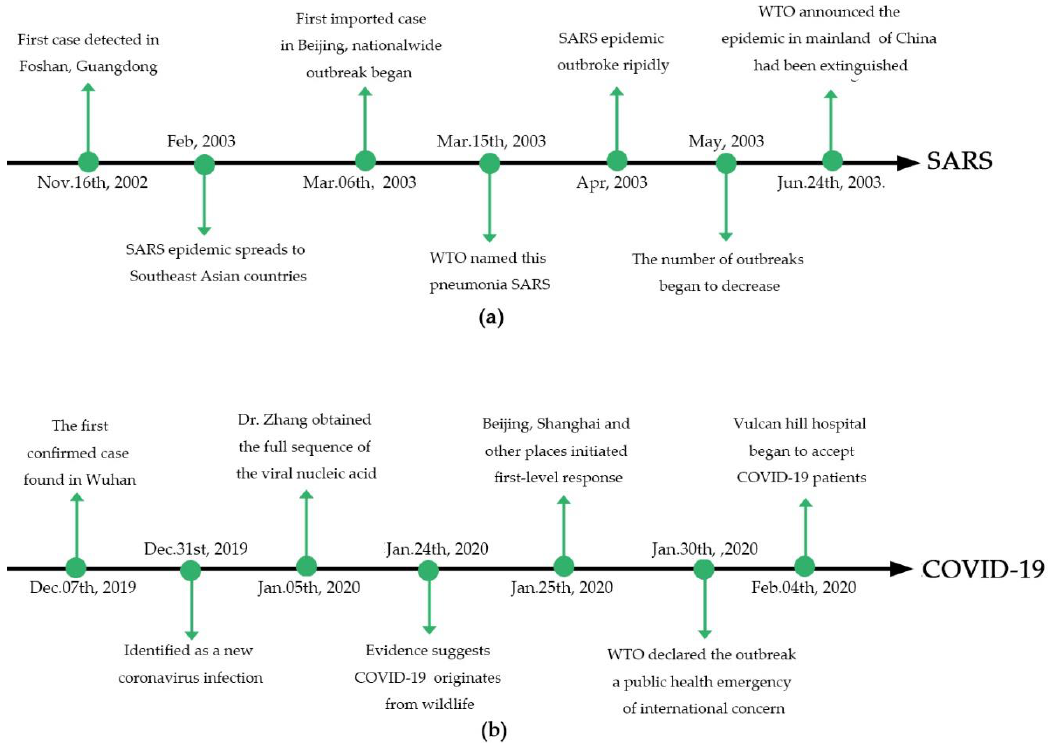
Figure 1. Timeline of SARS ( a ) and COVID-19 ( b ) epidemic development.